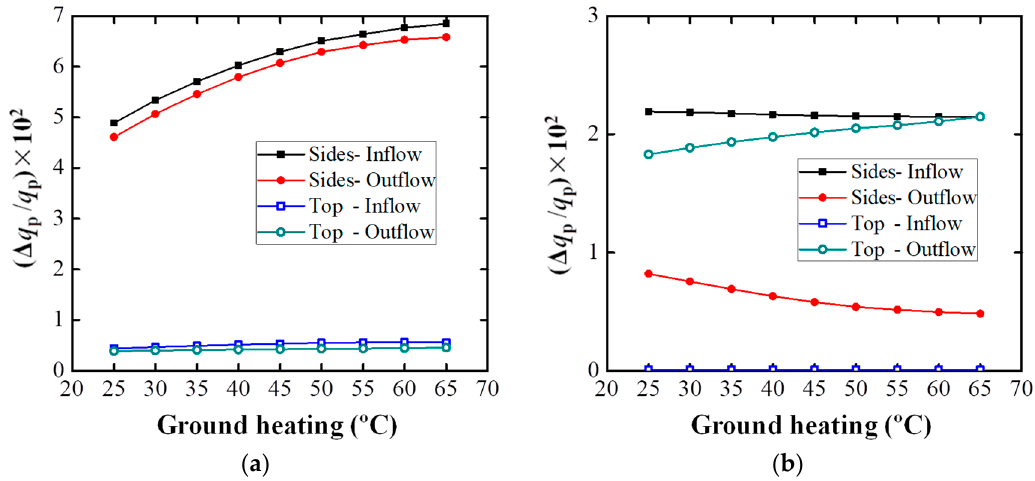
Figure 16. Contributions of air convection and turbulent diffusion to pollutant flow rates with ground heating (TSC): ( a ) contributions by air convection; ( b ) contributions by turbulent diffusion.